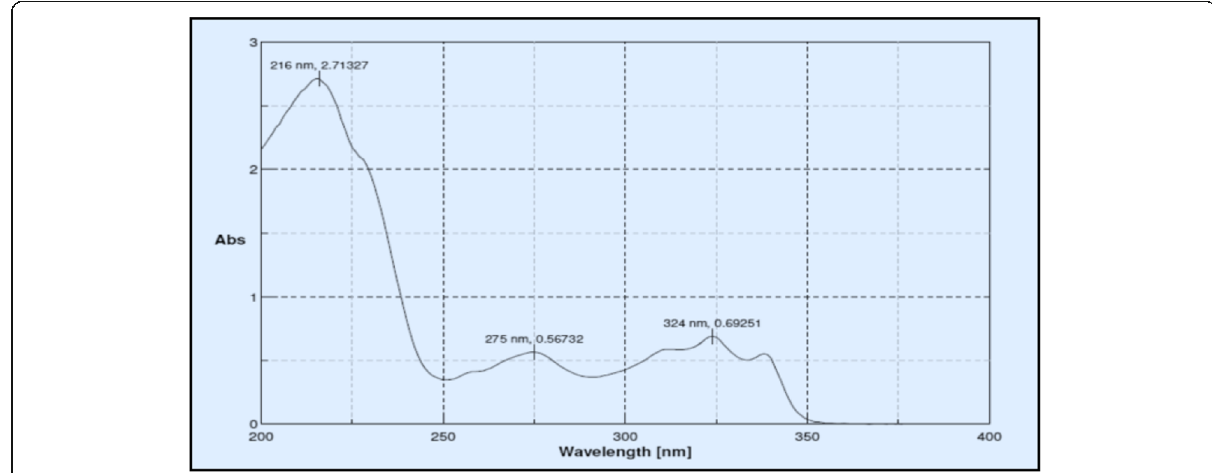
Fig. 2 UV spectrum of brexpiprazole in